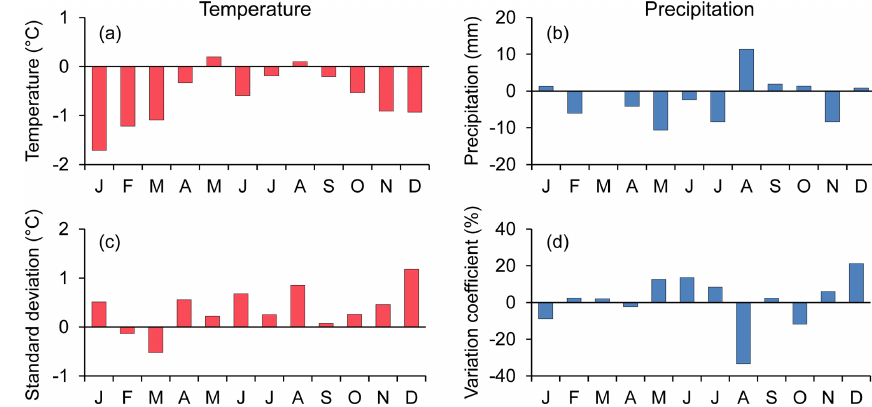
Figure 10. Comparison of monthly mean temperatures, precipitation totals, and their variability between the periods 1803 and 1830 and between 1961 and 1990 in Brno: differences in temperatures (a) and standard deviations (c) , precipitation (b) , and variation coefficients (d) . Positive differences express higher values in 1803–1830 and negative differences in